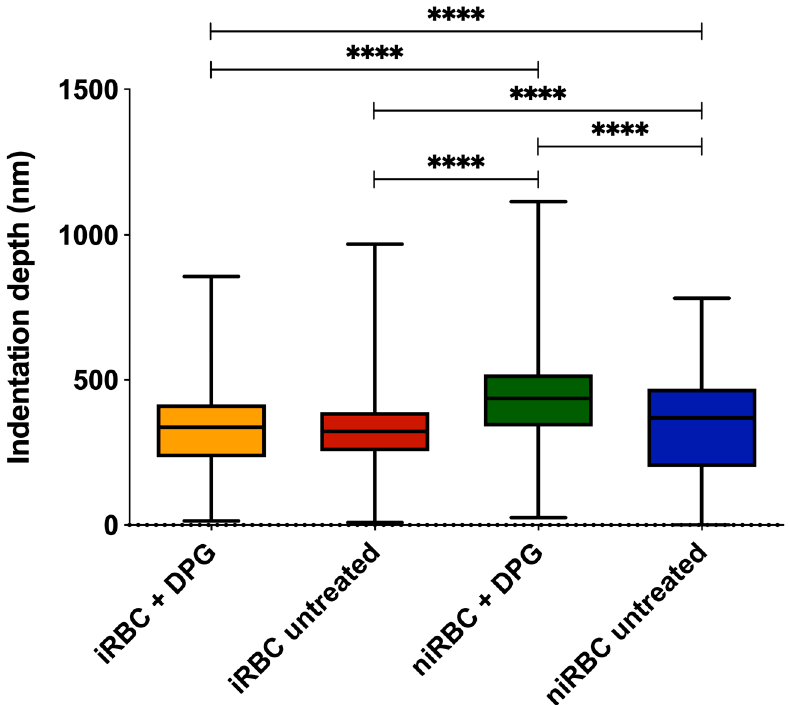
Figure 2. RBC indentation depth measured by AFM force spectroscopy of infected and noninfected RBCs after 30 h of incubation with or without 2,3-DPG 8 mM. Parasites in infected samples were at the trophozoite stage. This figure includes data from three independent experiments. iRBC + DPG—infected RBCs treated with 2,3-DPG ( n = 1573); iRBC untreated—untreated infected RBCs ( n = 1126); niRBC + DPG—noninfected RBCs treated with 2,3-DPG ( n = 1436); niRBC untreated—untreated noninfected RBCs ( n = 1358). p -values were generated by Dunn’s multiple comparisons test (**** p < 0.0001). Box plots: error bars represent minimum and maximum values; box higher and lower values represent the limits of the 1st and 3rd quartiles; lines represent mean for each sample group. All descriptive statistics and p -values are presented in Table S2.